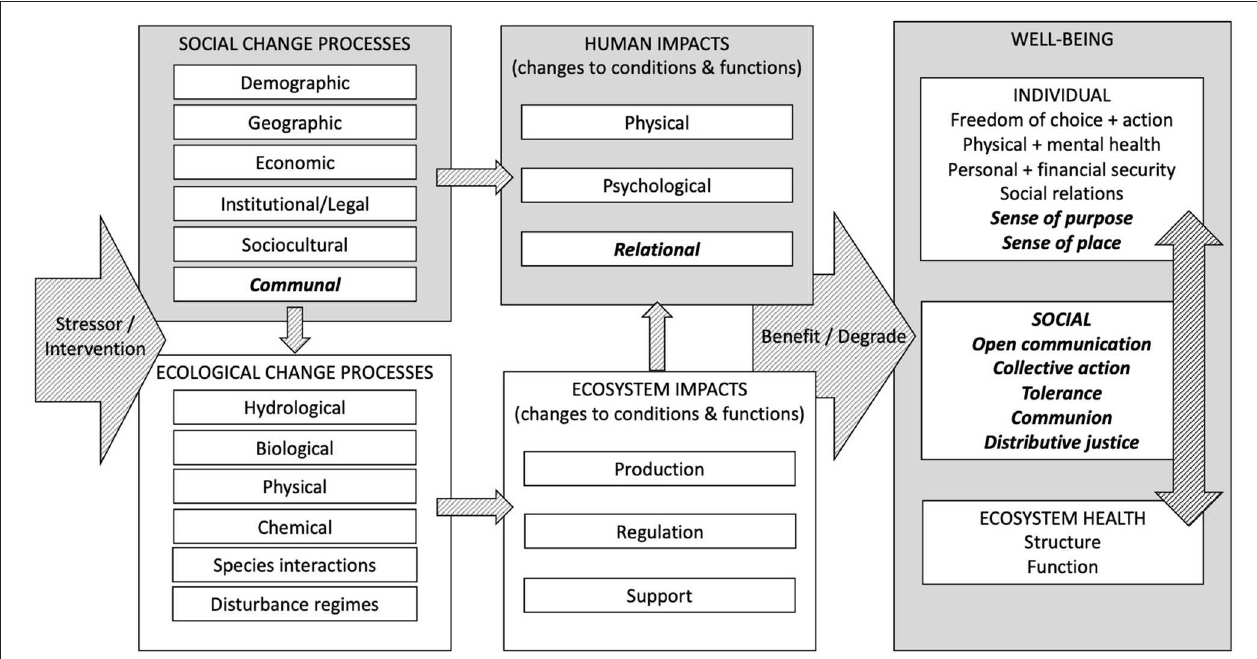
FIGURE 5 | Integrated framework that synthesizes social change processes, human impacts, and well-being (gray boxes) with impact pathway heuristics (Slootweg et al., 2001 ), ecological processes, and ecosystem services (i.e., nature’s contributions to well-being, Díaz et al., 2018) to show how human well-being and ecosystem health benefit from (or are degraded by) both nature’s and society’s contributons. Concepts in bold italics are key dimensions grounded in our data and analysis that expand established frameworks commonly used to illustrate human-nature relationships and pathways of